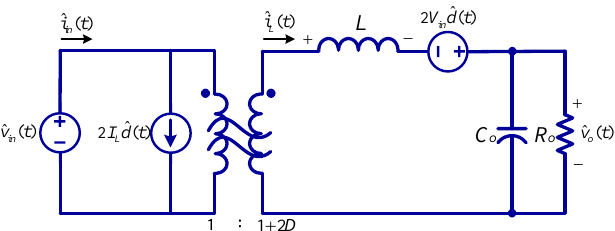
Figure 5. Small-signal AC equivalent circuit of the 3SSC-A-based boost. By analyzing the transfer function G vd , the proposed converter behaves as a minimum-phase system, due to the absence of right-half-plane (RHP) zeros. Therefore, the controller design process is simplified for the 3SSC-A-based boost converter and the problems associated with right-half-plane (RHP) zeros are eliminated. Thus, it is possible to obtain a satisfactory dynamic response without implementing an additional control loop. Moreover, it is observed that the dynamic characteristics are similar to the classic buck converter operating in CCM, which can be mathematically evidenced by the transfer function expressed in (35). It differs from the transfer function of the boost 3SSC-B-based converter presented in [31], which has characteristics like the classic boost converter.